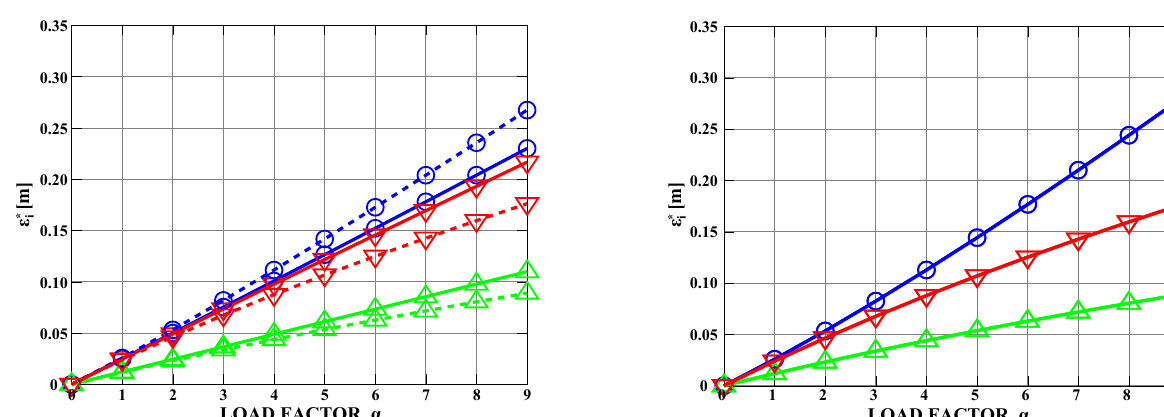
( (cid:13) ), ε ∗ ( 4 ), ε ∗ ( 5 ). 1 2 3